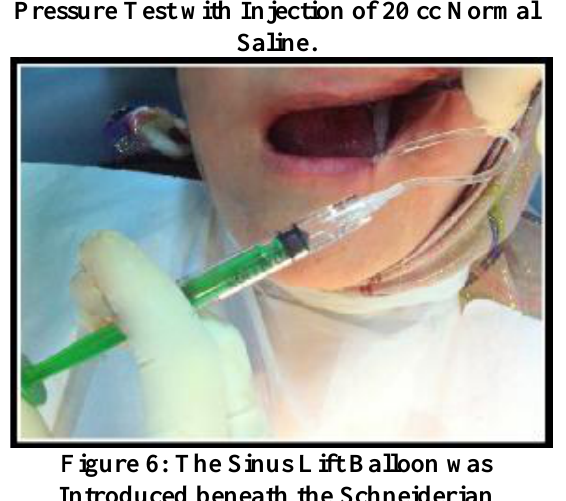
Figure 8: Post-Operative OPG Show Distribution of Dental Implants and the Augmented (R and L) Maxillary